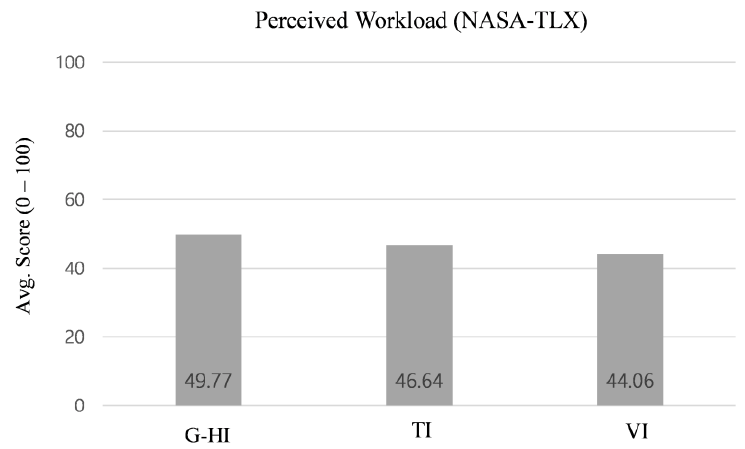
Figure 9. National Aeronautics and Space Administration Task Load Index (NASA-TLX) scores for the three input interactions.